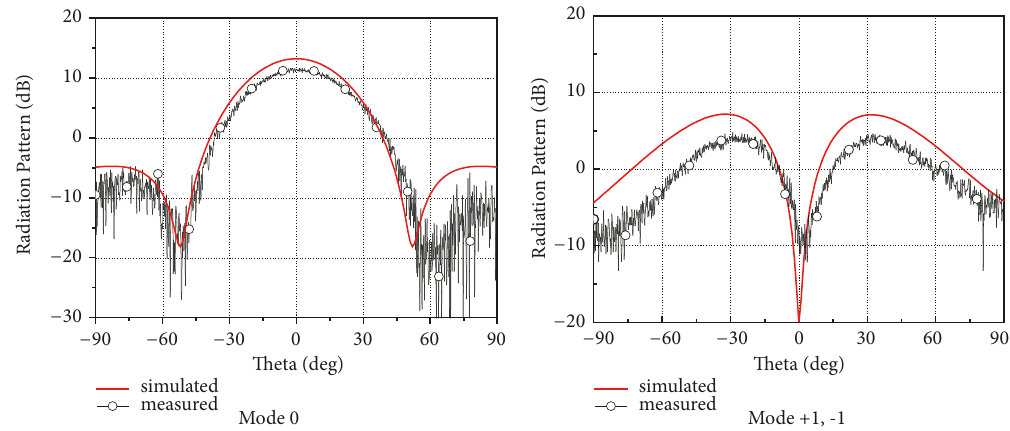
Figure 12: Simulated and measured